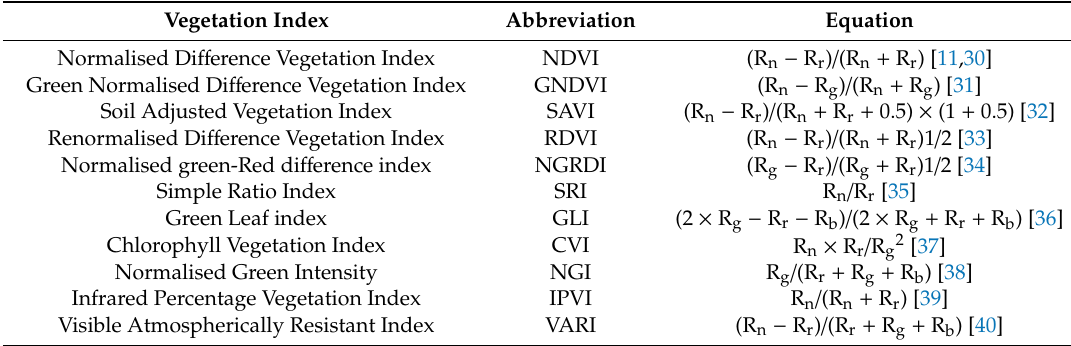
Table 2. List of the broadband vegetation indices used in this